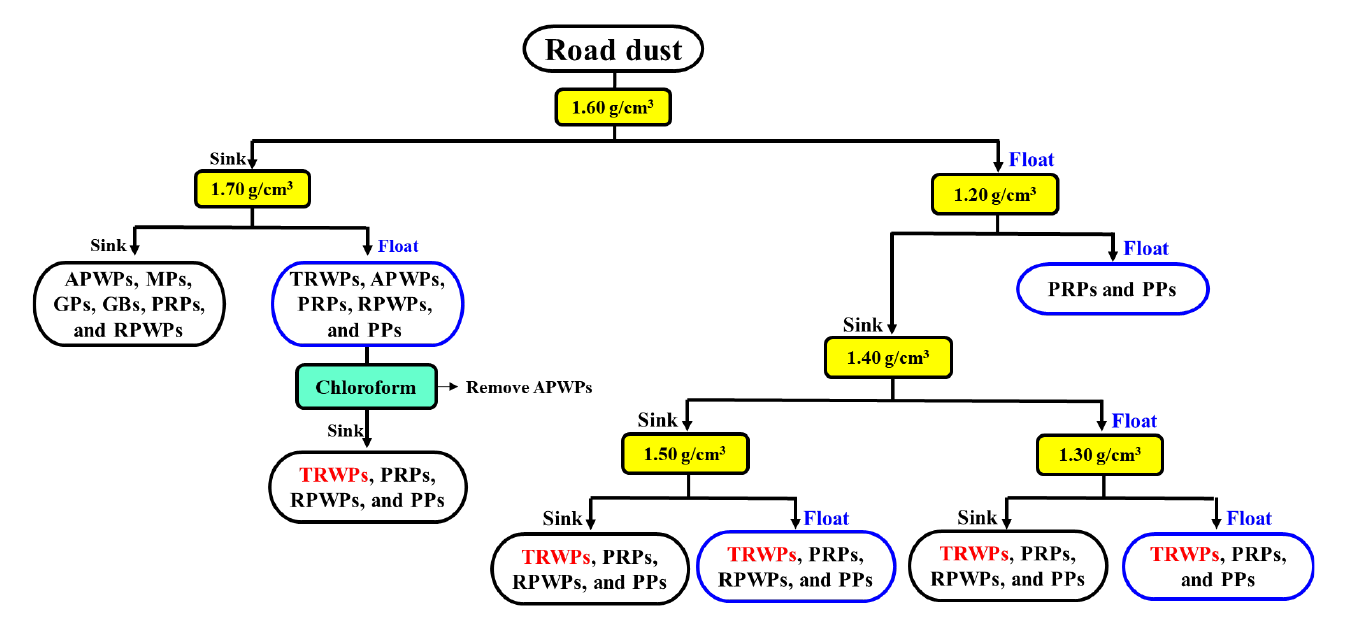
Figure 5. Separation procedure of TRWPs from road dust by the density difference.